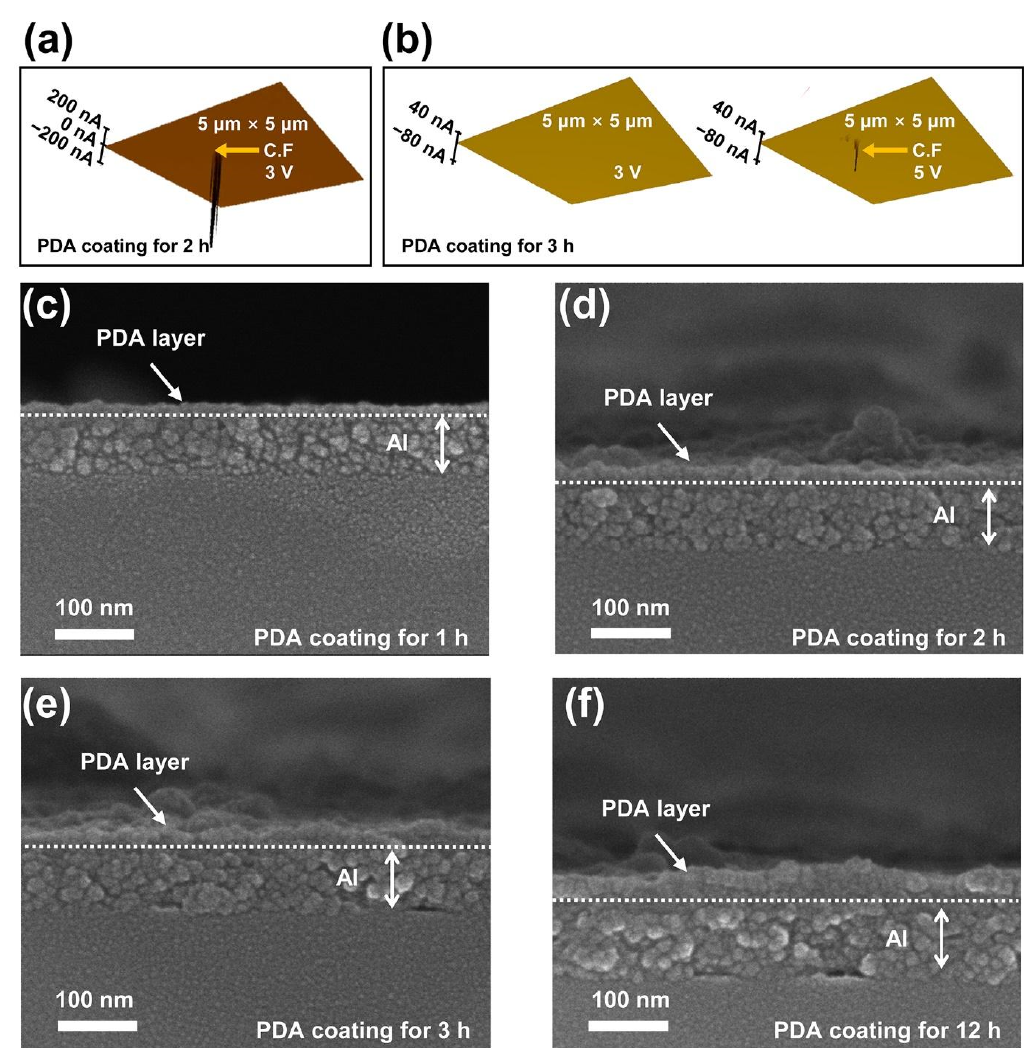
Figure 3. The measured conductive filament in the PDA/Al structure coated with a PDA layer for ( a ) 2 h and ( b ) 3 h with the aid of the C-AFM. The cross-section images of the PDA/Al structure coated with a PDA layer for ( c ) 1 h, ( d ) 2 h, ( e ) 3 h, and ( f ) 12 h, as observed with a scanning electron